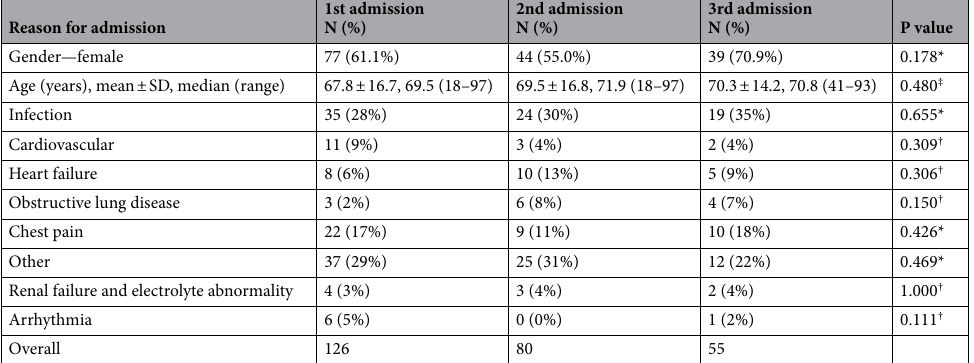
Table 2. Patients’ reason for admission stratified between admissions. *2-sided Pearson Chi Square. ‡ 2-sided Independent Sample t-Test. † 2-sided Fisher-Freeman-Halton Exact Test.